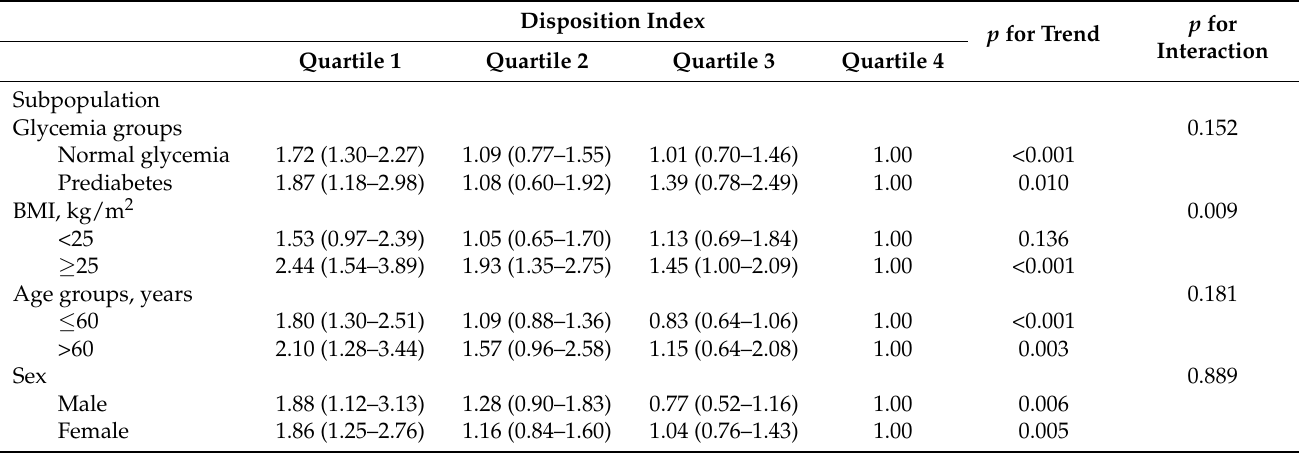
Table 6. Adjusted odds ratios (95% confidence intervals) of NAFLD according to DI quartiles using logistic regression in various